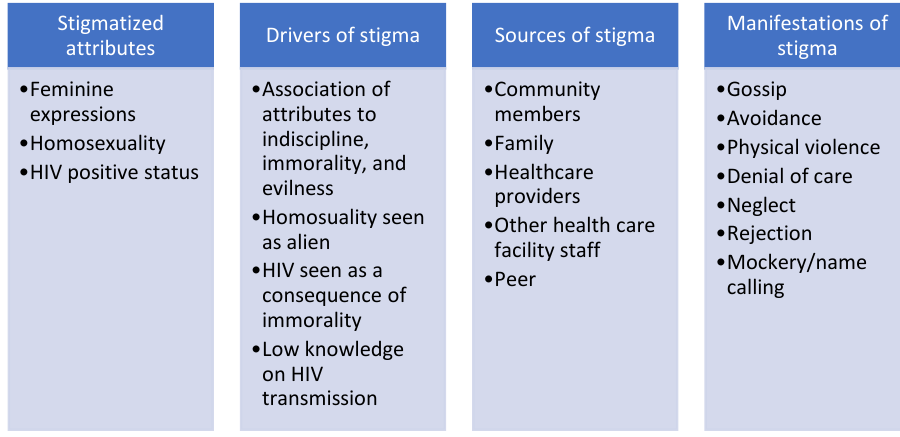
Figure 1, participants reported facing intersectional stigma at multiple levels (e.g., family, community members, friends, and healthcare workers), and expressed interest in working with MSM-friendly organizations compared to general hospitals. Participants identified the normalized linkage of same-gender sexual activities with foreign culture, immorality, evil, and indiscipline as driving factors of their experiences of intersectional stigma in Ghana. We also observed internalized same-gender stigma, gender nonconformity stigma, and HIV stigma among some participants. They recommended that interventions address HIV risk and stigma among MSM and health care settings. Detailed qualitative processes and findings are reported elsewhere.